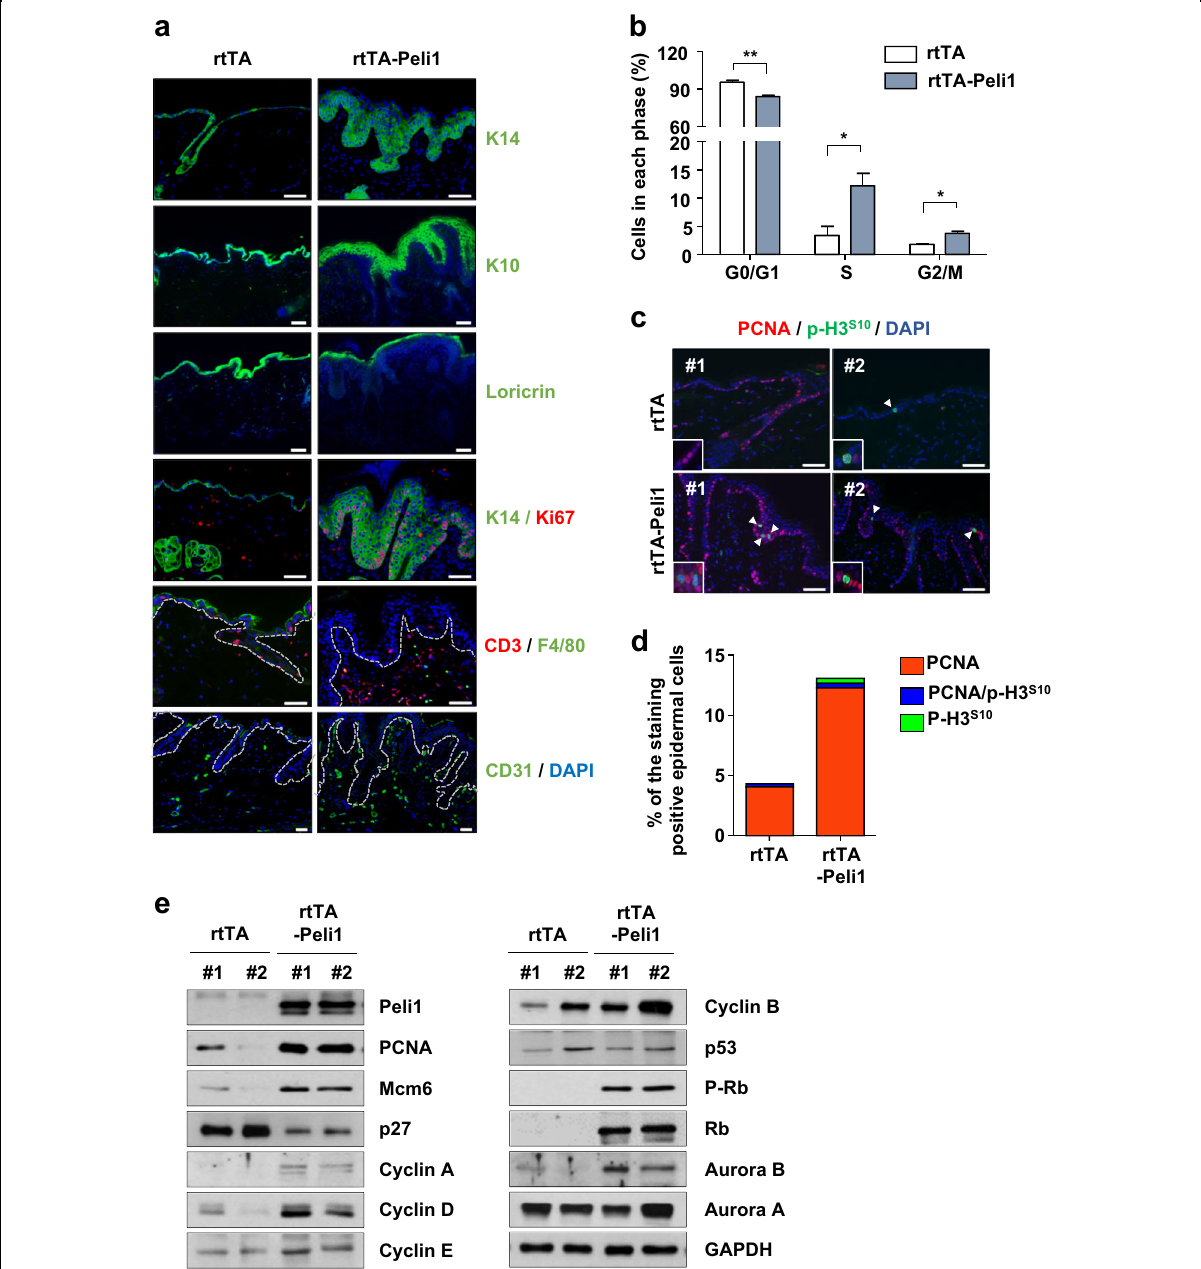
Fig. 5 Activation of Peli1 expression causes epidermal hyperplasia and leads to aberrant cell cycle progression at S-G2/M phases. a Adult rtTA control mice and rtTA-Peli1 inducible transgenic mice were treated with doxycycline (2 mg/mL) for 12 weeks. Representative immuno fl uorescence images of skin sections showing the expression of keratinocyte differentiation markers (keratin 14, keratin 10, and loricrin), a proliferation marker (Ki67), dermal in fi ltrated immune cell markers (CD3 and F4/80), and an angiogenesis marker (CD31). The dotted line indicates the border between the epidermis and dermis. Scale bars, 50 μ m. b Primary keratinocytes were isolated from rtTA or rtTA-Peli1 mice after 24 weeks of doxycycline treatment. Single-cell suspensions of primary keratinocytes were fi xed and stained with propidium iodide for DNA analysis via fl ow cytometry. Summary data are shown. Data are presented as the means ± SEMs ( n = 3). * P < 0.05, ** P < 0.01, two-way ANOVA. c Double immuno fl uorescence staining for PCNA (red) and phospho-H3 S10 (green) expression in skin sections of rtTA and rtTA-Peli1 mice after 24 weeks of doxycycline treatment. Scale bars, 50 μ m (inset magni fi cation, ×630). d Quanti fi cation of positively stained keratinocytes in skin sections. PCNA: a marker of S phase; phospho-H3 S10 : a marker of mitosis; PCNA and phospho-H3 S10 double-positive: a marker of G2 phase. The results are presented as the means ± SEMs ( n = 5). e Immunoblot analysis of the indicated protein in skin tissues derived from rtTA and rtTA-Peli1 mice after 24 weeks of doxycycline